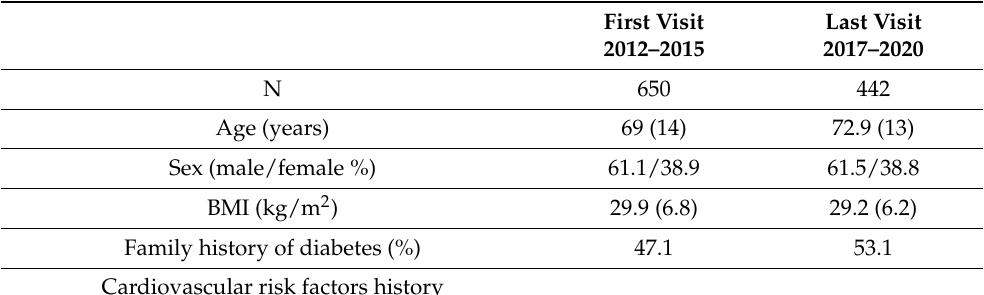
Table 2. General characteristics at baseline visits and at the end of follow-up